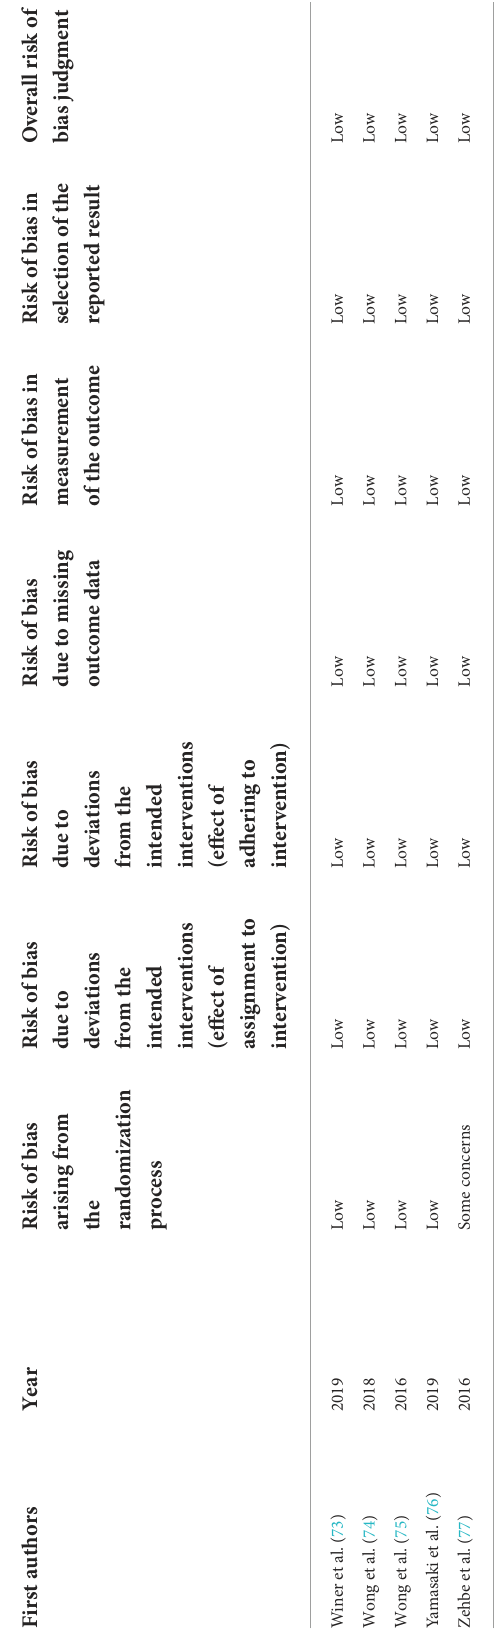
Figure 4 showed the RR of CCS uptake for HPV testing by self-sampler type. The results of those analyses showed a higher relative uptake for vaginal lavages (RR: 1.2; 95% CI: 1.1– 1.5), brushes (RR: 1.6; 95% CI: 1.5–1.7) and swabs (RR: 2.5; compared swabs and brushes and brushes and lavages showed a statistically significant difference ( p = 0.004 and p <